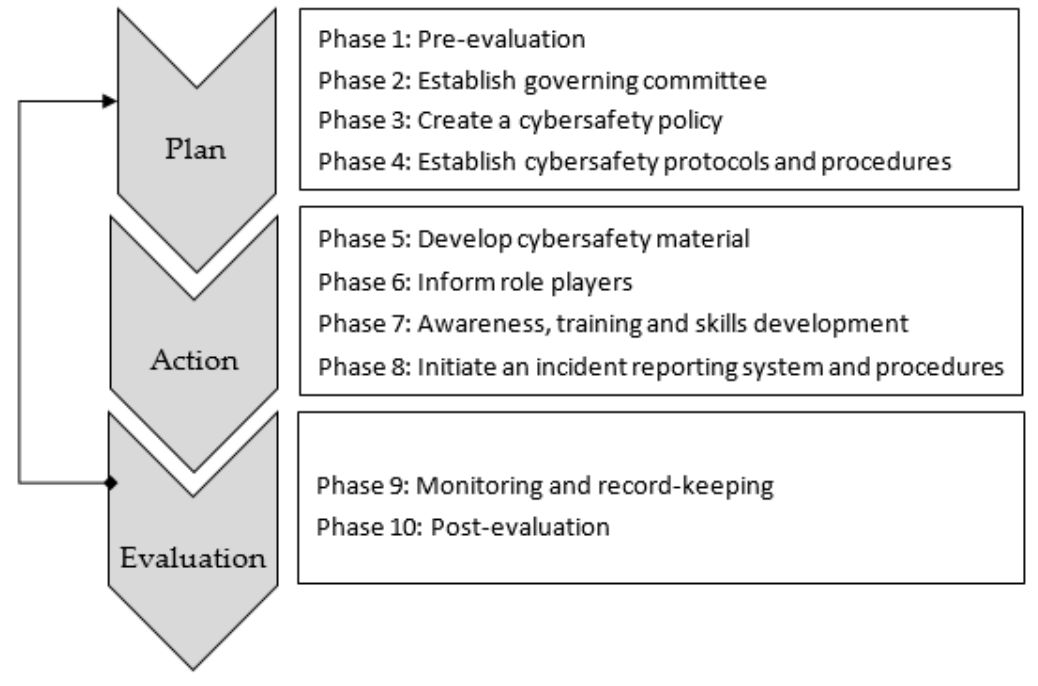
Figure 6. Ten-phase approach to cybersafety awareness.